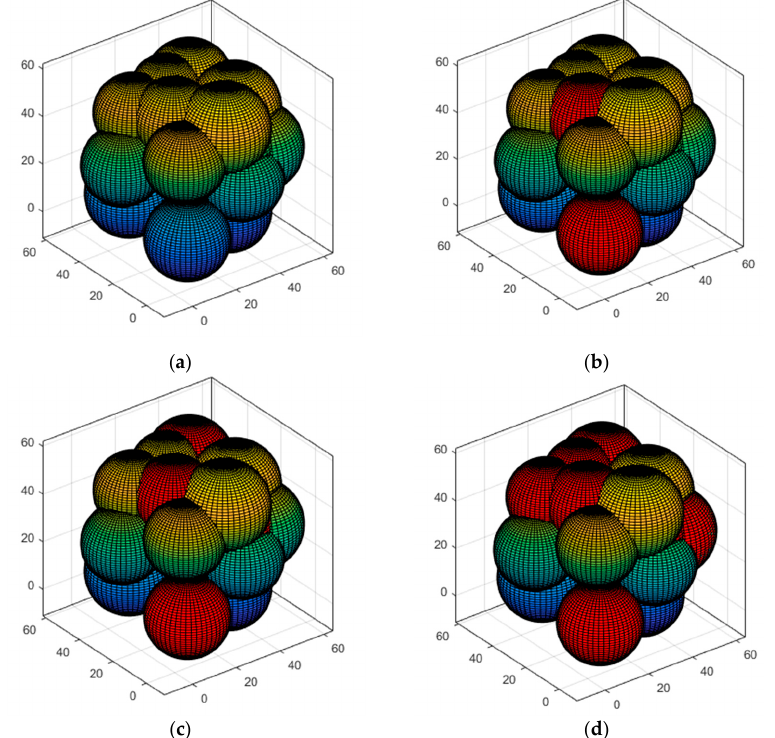
Sensors 2023 , 22 , x FOR PEER REVIEW Figure 11. Different rounds of coverage in small networks: ( a ) Network runs 50 rounds; ( b ) Network runs 5000 rounds; ( c ) Network runs 10,000 rounds; ( d ) Network runs 15,000 rounds.